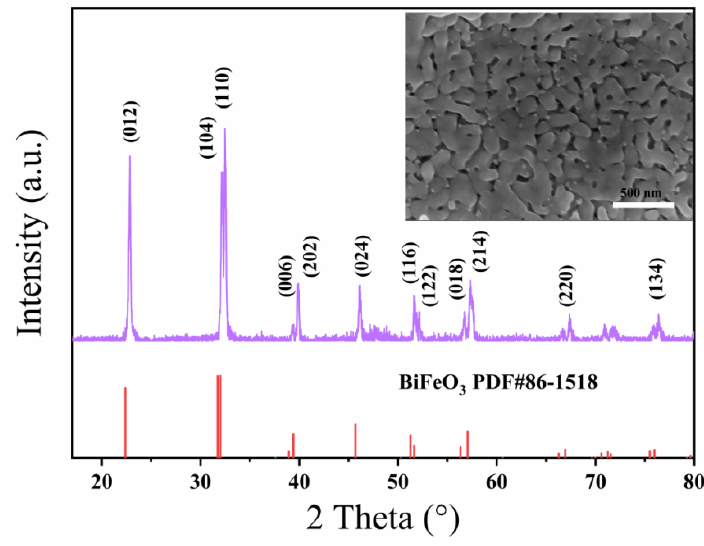
Figure 1. XRD pattern of BiFeO 3 film. Inset: SEM image of BiFeO 3 film.